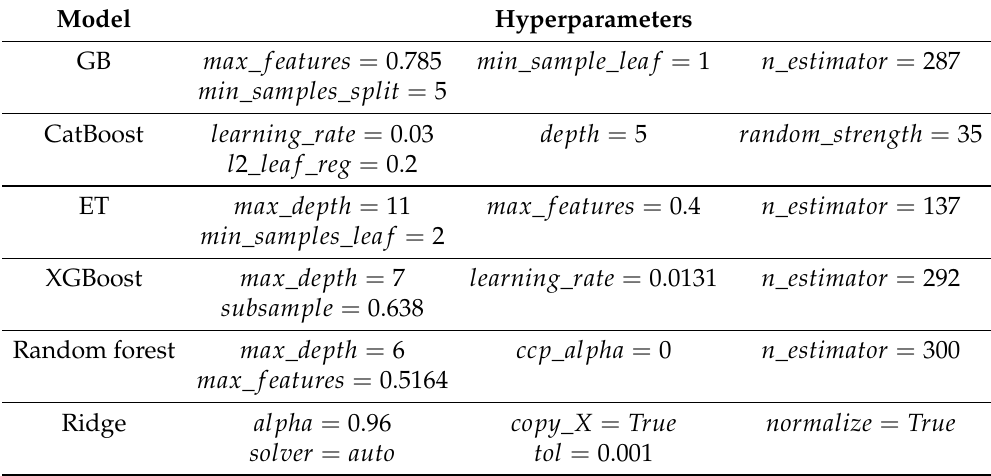
Table 3. Selected best hyperparameters for ML models after training